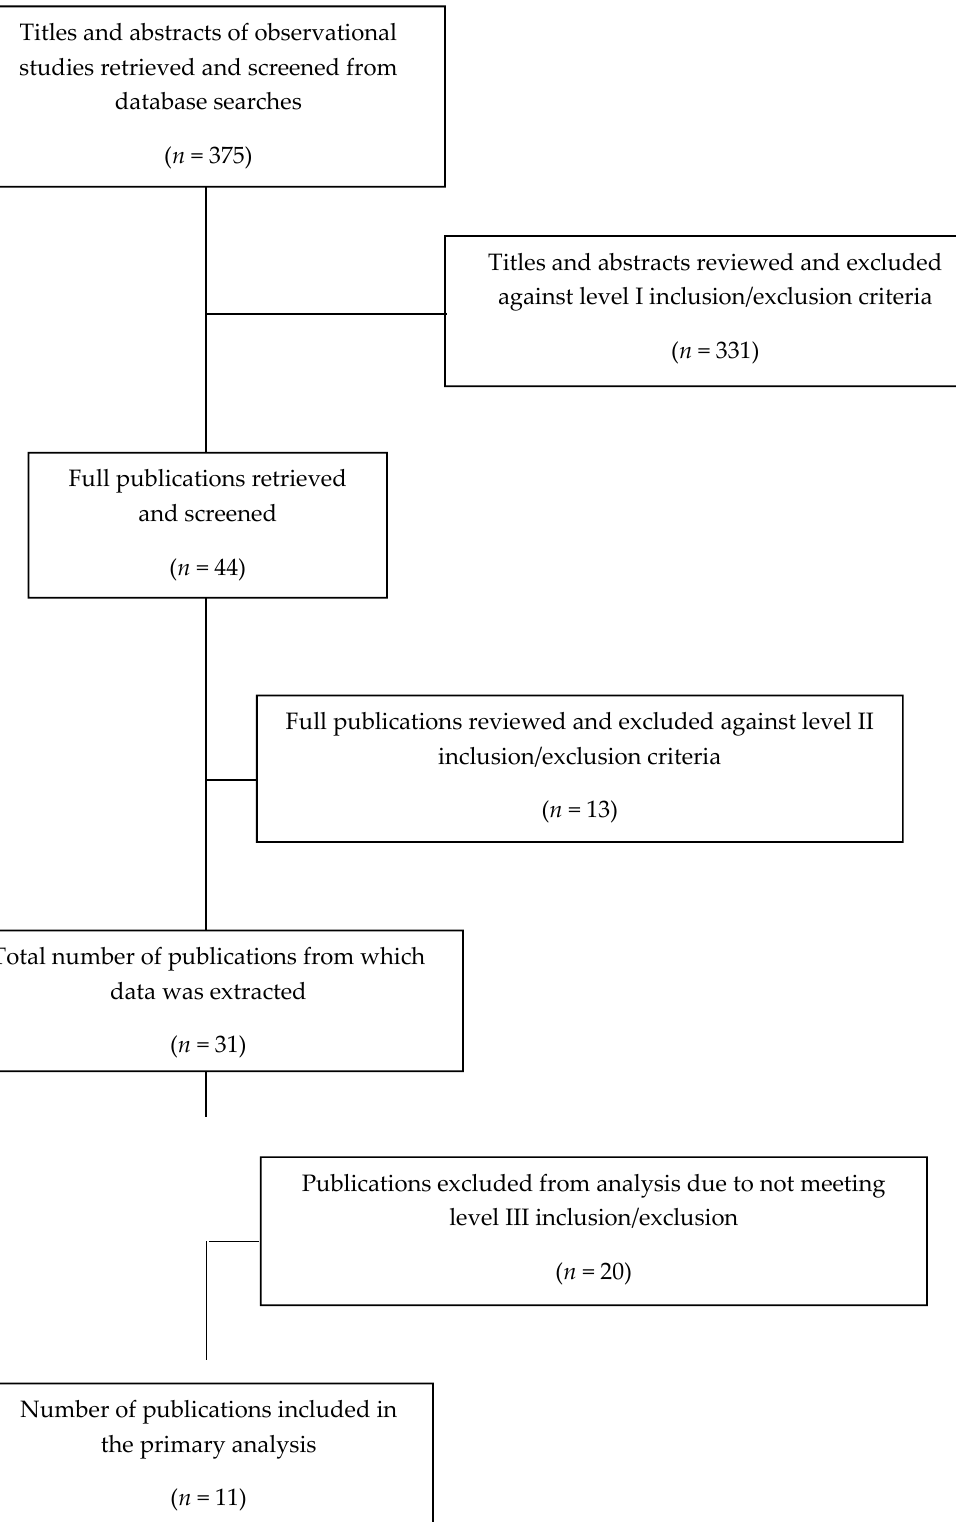
Figure 1. Flow diagram of literature search for observational study analyses inclusion.